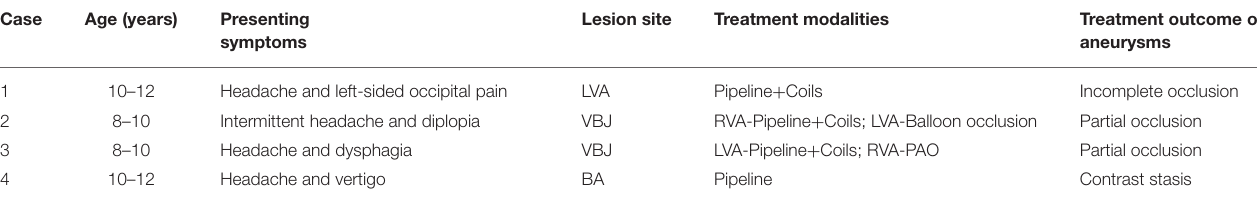
TABLE 1 | Patient demographics and clinical information on admission.